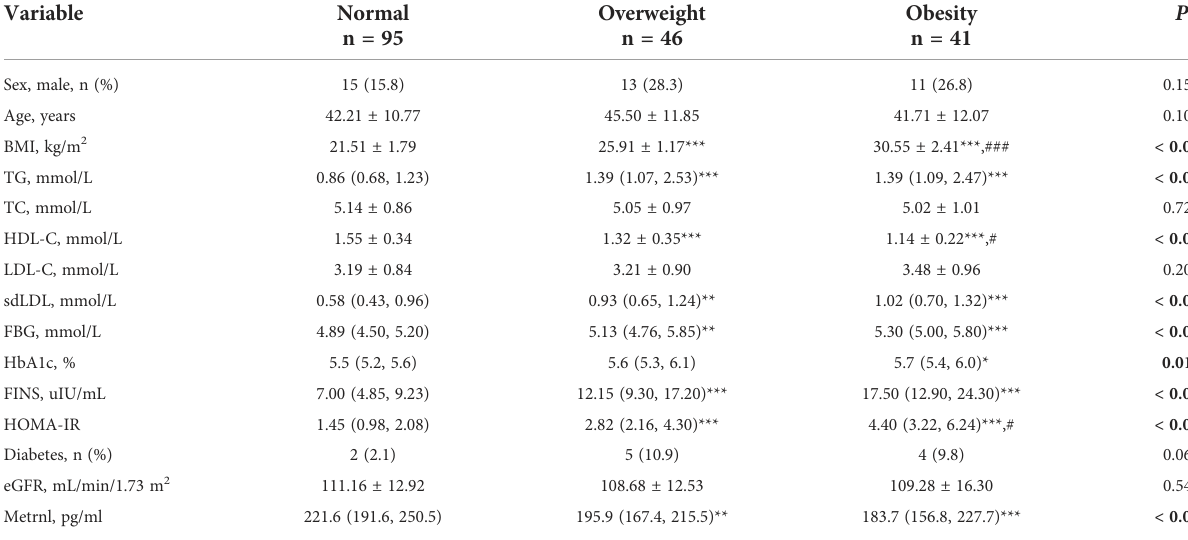
TABLE 1 Clinical and biochemical characteristics of all the study participants. Variable